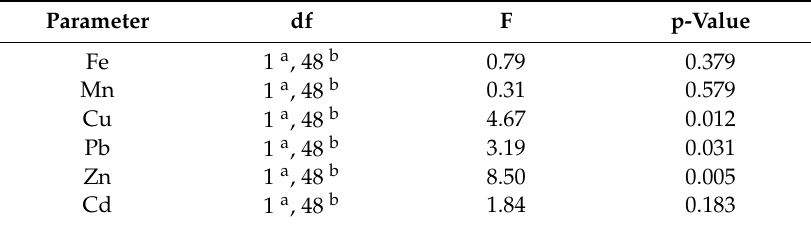
Table 3. One-way ANOVA, single-factor results comparing the wet and dry season. Parameter